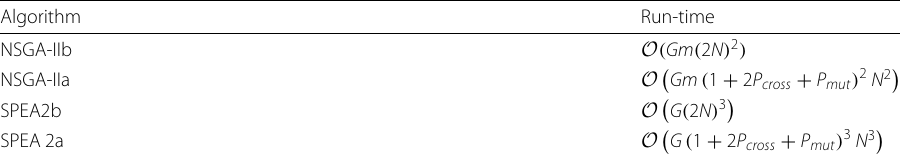
Table 1 Run time complexity for the algorithms